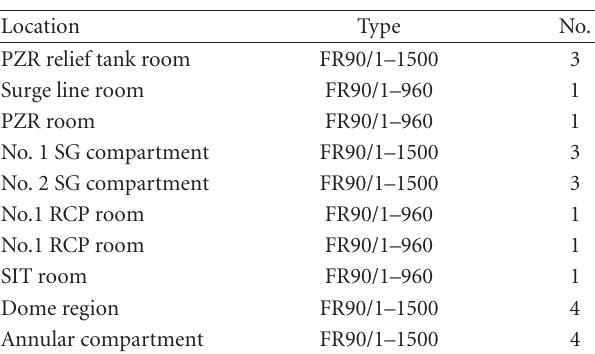
Table 1: Arrangement of recombiners.